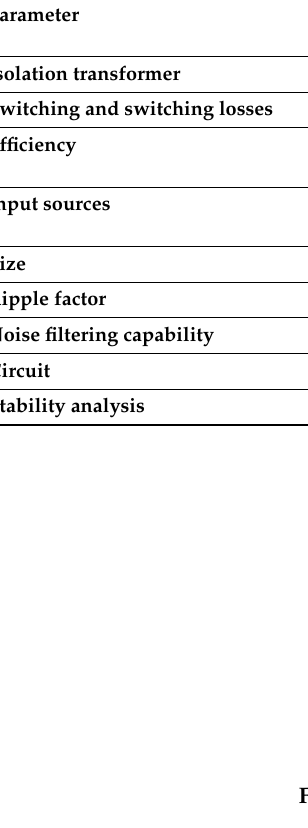
Table 1. Comparative analysis of the different DC-DC converter topologies [3].